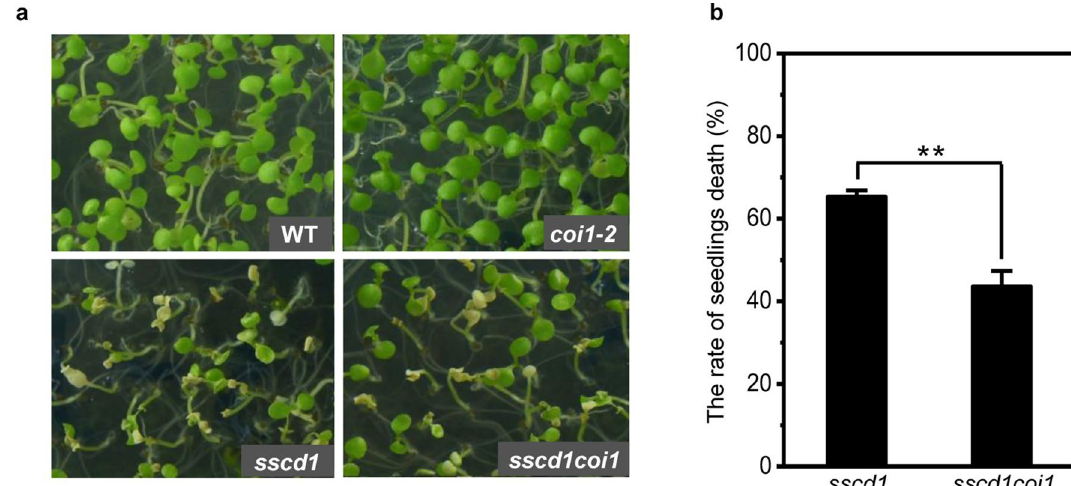
Figure 3. Cell death in sscd1 is reduced by mutation of COI1. ( a ) The phenotype of wild-type (WT), sscd1 , coi1-2 and sscd1coi1 seedlings grown on MS under SD for 7 days. ( b ) The rate of seedlings death in coi1-2 and sscd1coi1 seedlings grown on MS under SD for 7 days. SD, short day. Mean ± SE from three biological replicates. Asterisk ** represents the significance of differences (two-tailed student’s t-test) at the level of P <